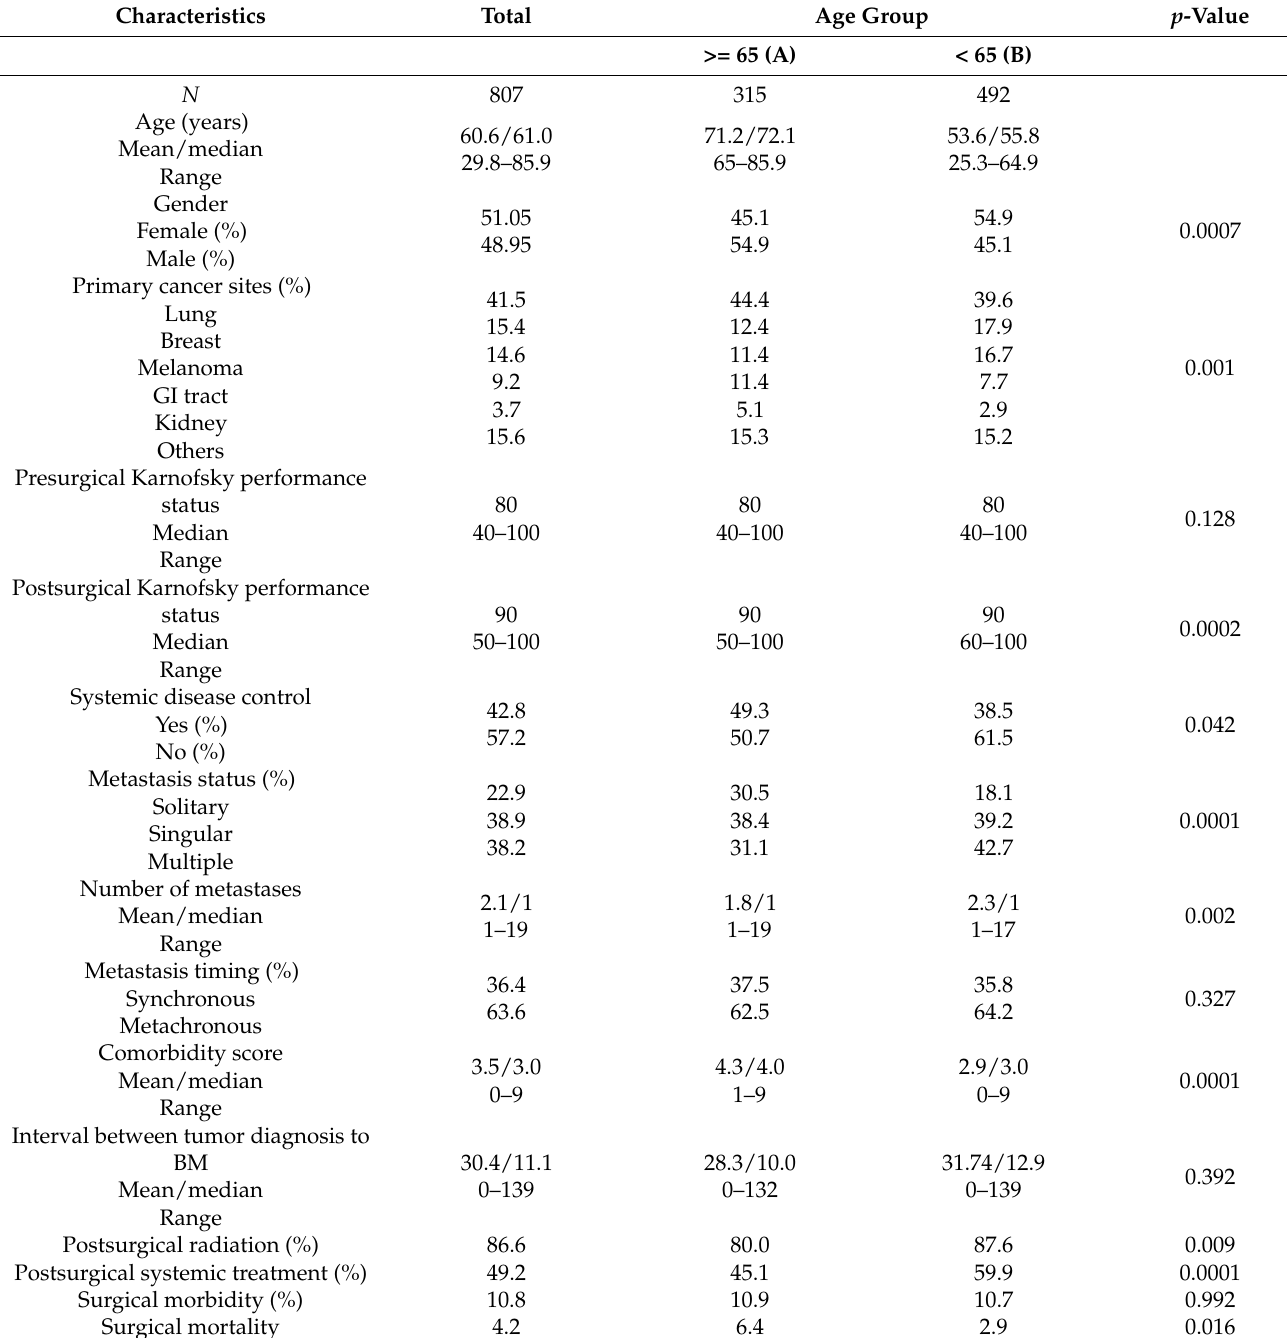
Table 1. Baseline characteristics of the entire patient population and stratified into age